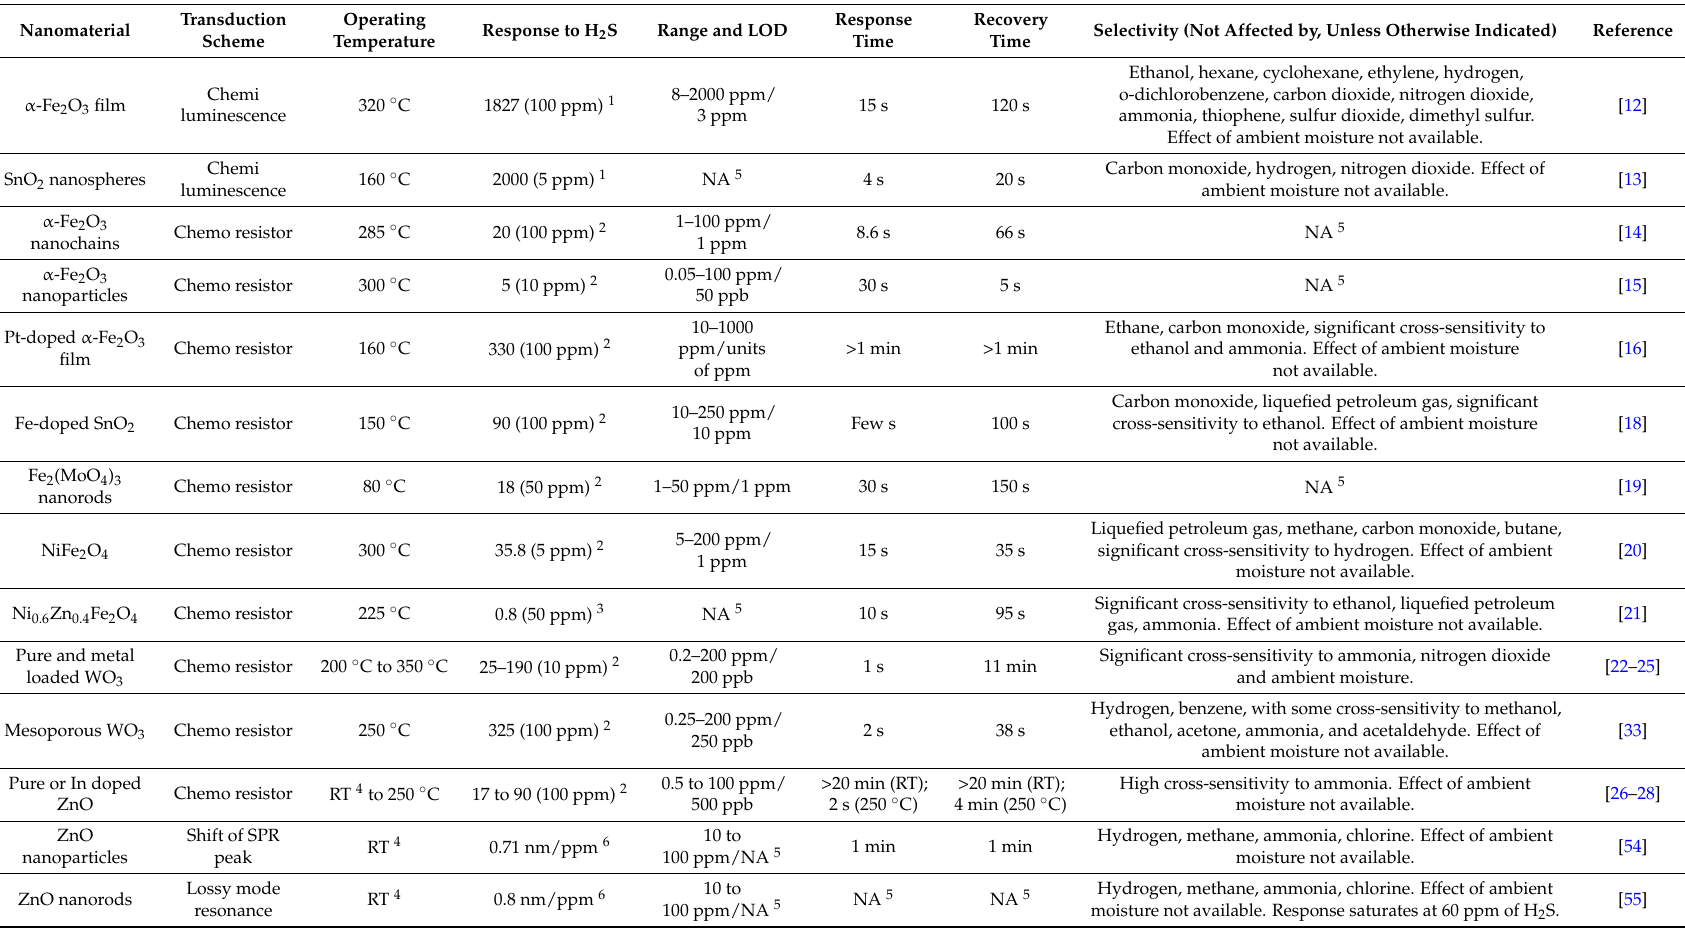
Table 1. Summary of the main properties and performance characteristics of the different nanomaterials employed in the detection of H 2 S